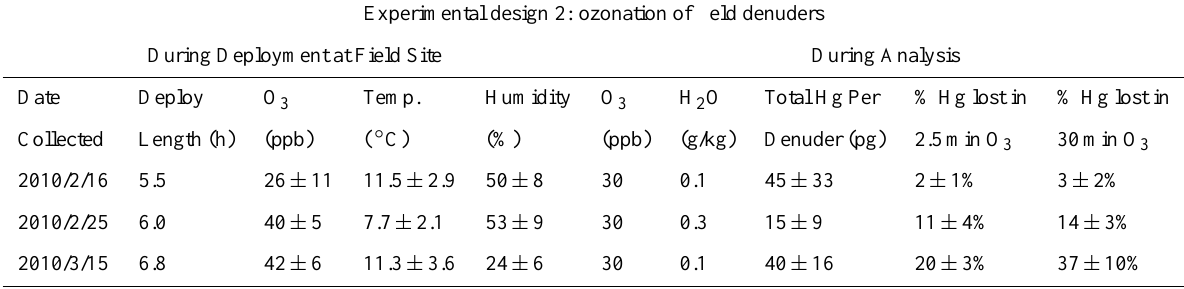
Table 2. Results of experiments in which denuders sampled ambient GOM at the Nevada field site. Denuders were analyzed via 30min of ozone followed by 30 min of heating at 500 ◦ C with no ozone. Experimental design 2: ozonation of field denuders During Deployment at Field Site During